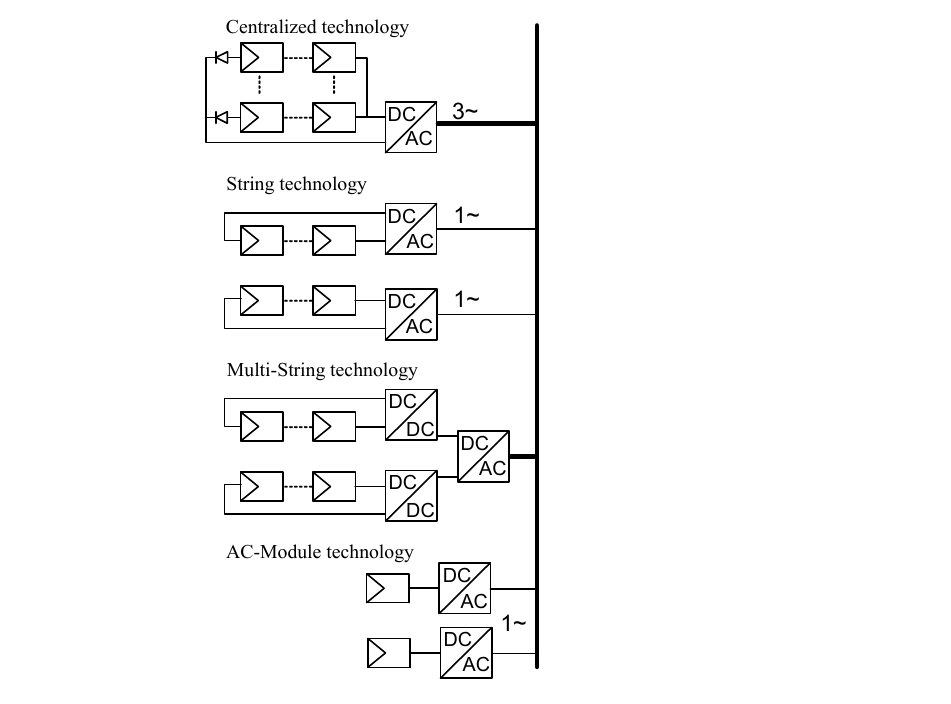
Figure 11. Commonly used PV inverter types [25].